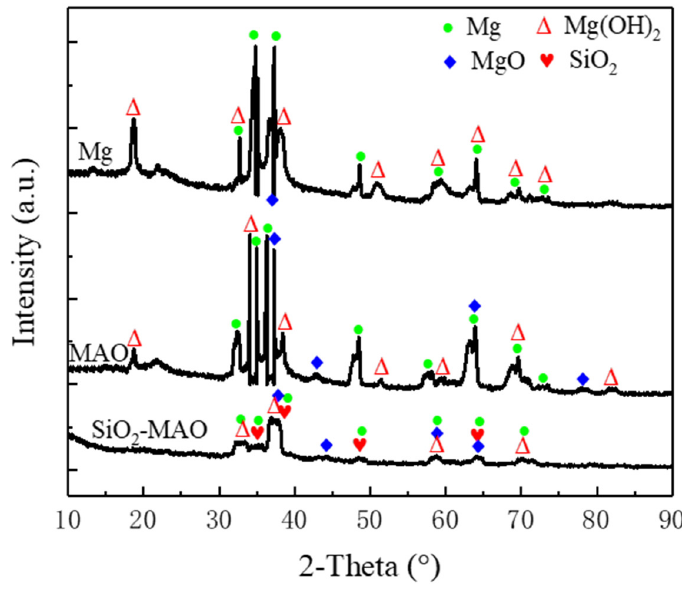
Figure 9. XRD results of the material phase of each sample after